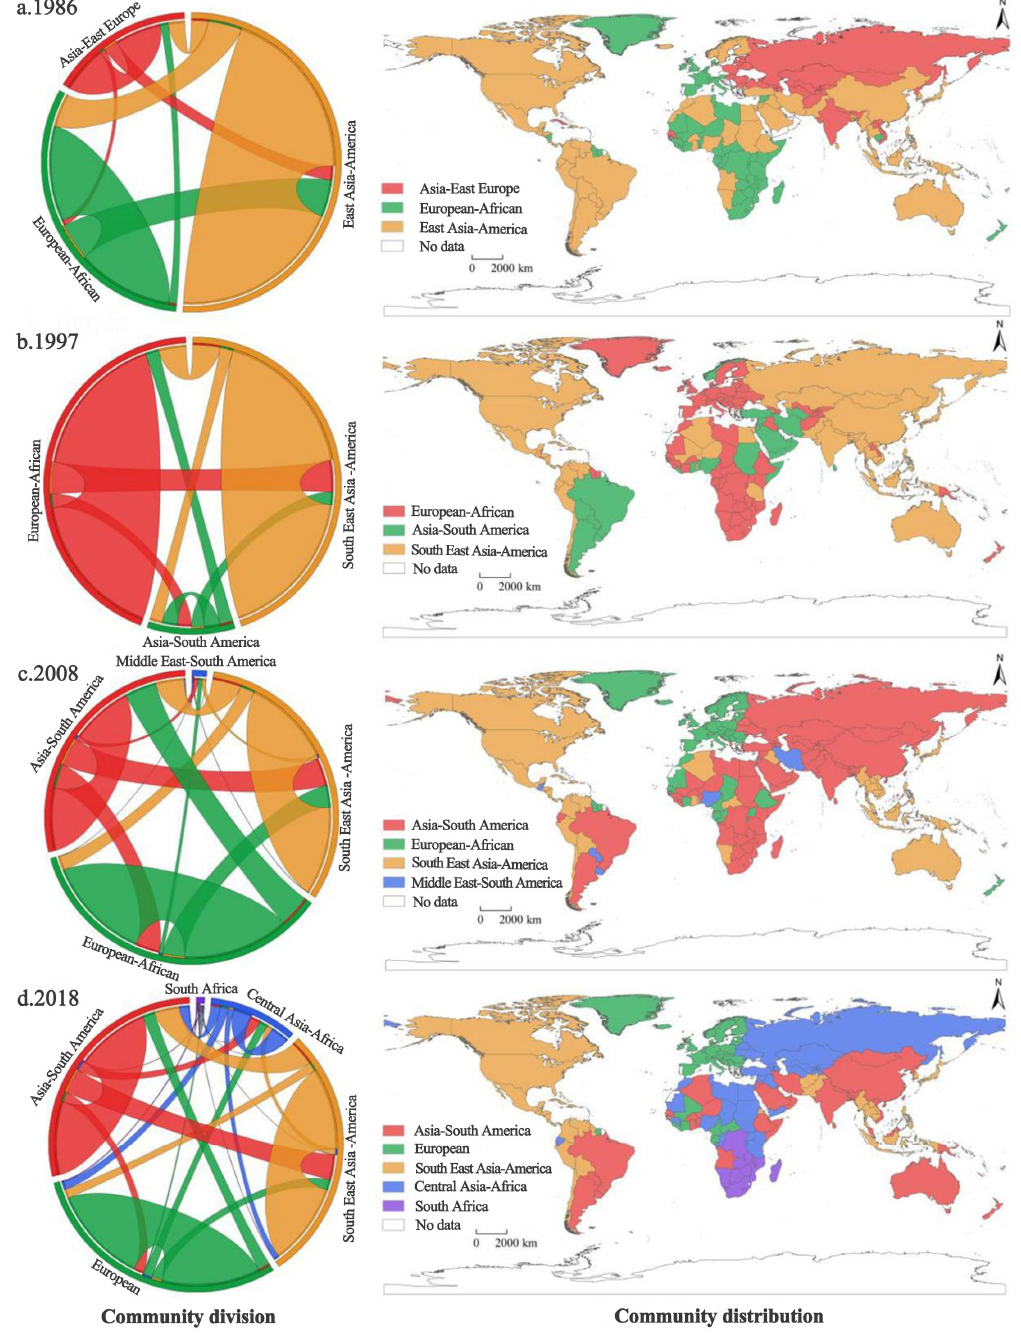
Figure 1. Community structure and distribution of global agricultural products trade network in ( a ) 1986, ( b ) 1997, ( c ) 2008, and ( d ) 2018.